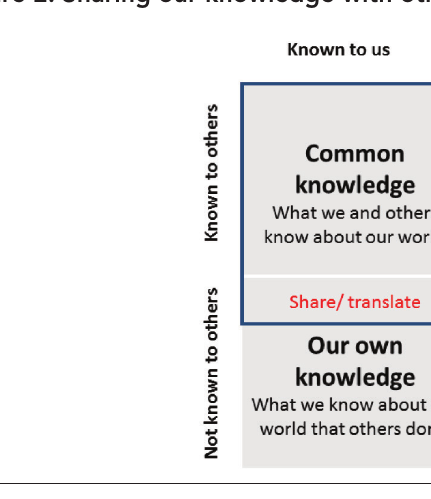
Figure 2: Sharing our knowledge with others